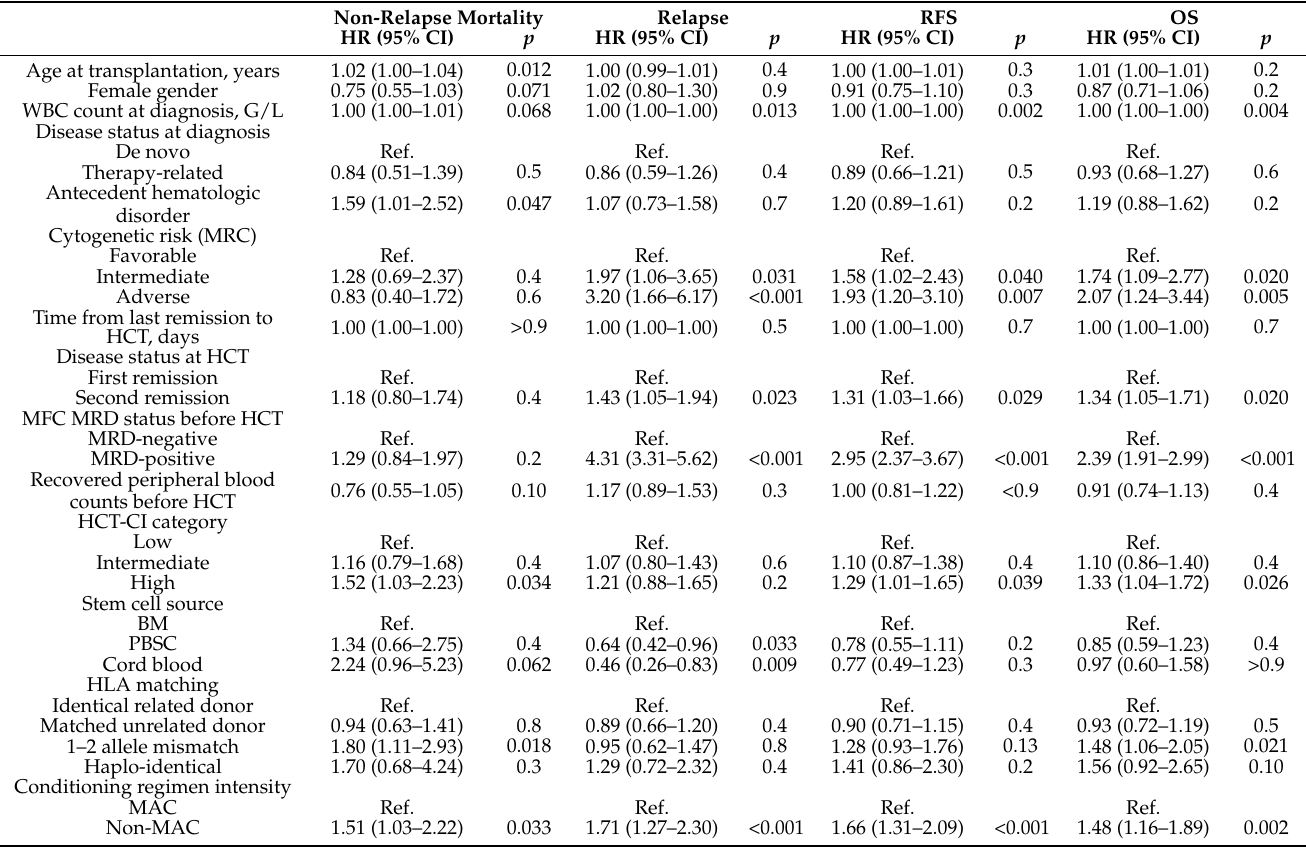
Table 3. Multivariable regression models of study